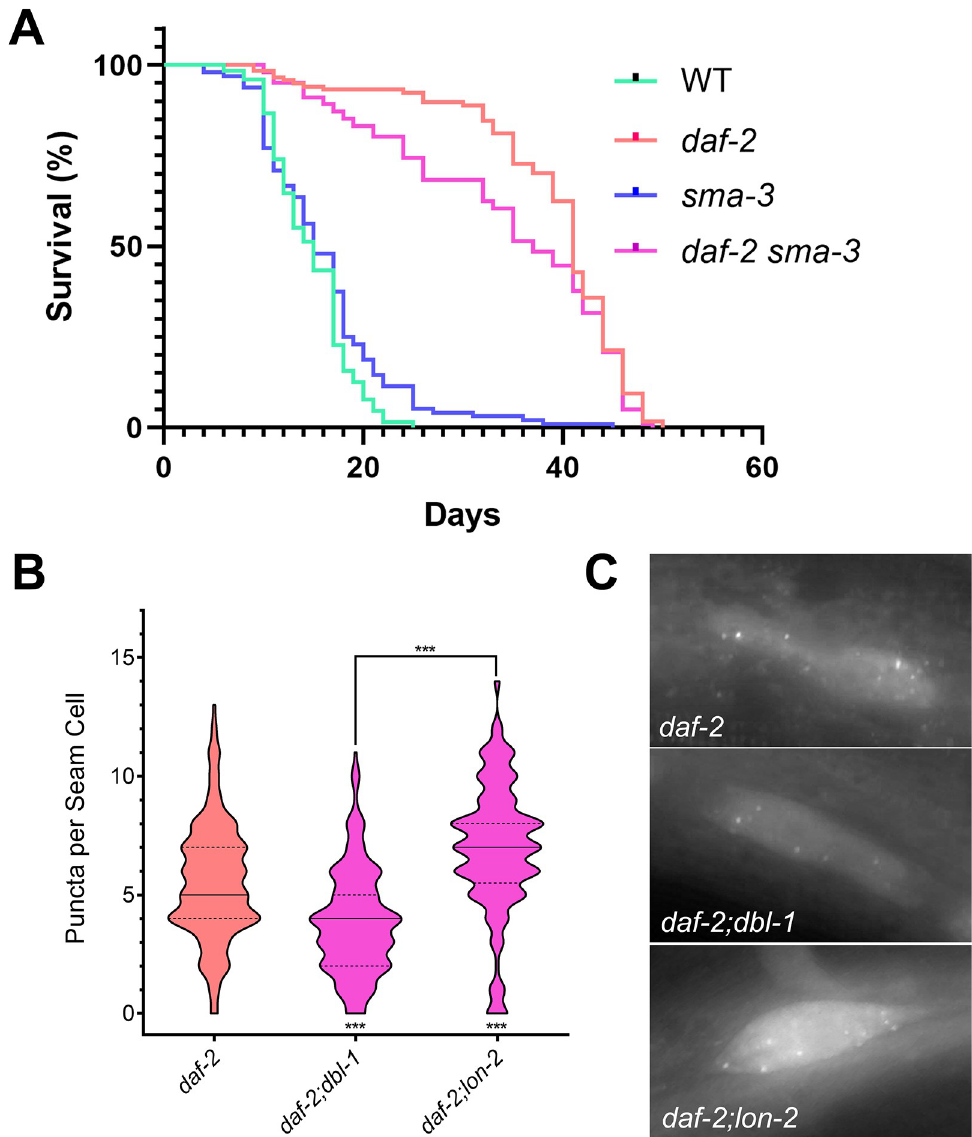
Fig 4. DBL-1 signaling promotes autophagy in a DAF-2-sensitized background. A) Loss of sma-3 induces no noticable effect on lifespan compared to control animals. However, daf-2;sma-3 animals exhibit a reduced median lifespan compared to daf-2 single mutants (p = 0.05 Mantel-Cox, p = 0.01 Gehan-Breslow-Wilcoxon). B) Under conditions that induce autophagy such as a reduction in DAF-2 signaling, DBL-1 signaling promotes autophagy, as daf-2(e1370);dbl-1 (wk70) mutants show a reduction in GFP puncta, whereas daf-2(e1370);lon-2(e678) mutants show an increase in puncta. C) Images of GFP::LGG-1 localization in seam cells of DBL-1 pathway mutants under autophagic induction via daf-2 loss of function at 630X. All animals were grown at 20˚C and imaged at the L3 larval stage. ��� p value < 0.001, solid lines denote the median, dashed lines denote quartiles.